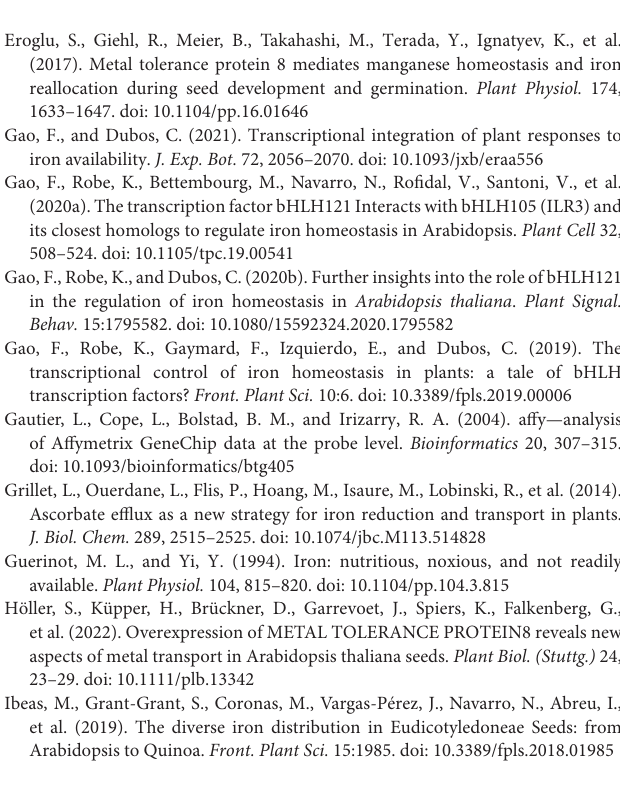
Supplementary Figure 2 | Expression of FERRITIN genes in B3 mutants. Transcriptome datasets from seeds of B3 mutants (Yamamoto et al., 2014) were obtained from the GEO database (GEO accession GSE61686). We show the log 2 normalized expression for FER1 , FER2 , FER3 and FER4 in developing seeds dissected from siliques from the abi3-6 , fus3-3, and lec2-1 mutants. DAF: days after flowering. The asterisks show means that significantly differ between mutants and their respective WT control ( t -test, p ≤ 0.05). Supplementary Figure 3 | Gene regulatory network controlling FERRITIN gene expression in seeds. We obtained a list of differentially expressed genes from seed transcriptome datasets of B3 mutants and searched for transcription factor-target gene interaction data in the plant cistrome database (O’Malley et al., 2016), the CIS-BP database (Weirauch et al., 2014) and the Arabidopsis Gene Regulatory Information Server AGRIS (Yilmaz et al., 2011) in order to build a regulatory network. Transcription factor-target gene pairs were further filtered by coexpression (expression correlation) during seed development (Schmid et al., 2005). From this network, we extracted regulatory interactions between FERRITIN genes and transcription factors and visualized the network in Cytoscape (Shannon et al., 2003). In the network, triangles represent transcription factors and rectangles represent genes. The edges connecting the nodes represent regulatory interactions from AGRIS (red edges) and CIS-BP (blue edges). Arrow edges represent positive regulation (activation) and T edges represent negative regulation (repression) based on expression correlation. Supplementary Figure 4 | Expression of VIT1 and MTP8 genes in B3 mutants. Transcriptome datasets from seeds of B3 mutants (Yamamoto et al., 2014) were obtained from the GEO database (GEO accession GSE61686). We show the log 2 normalized expression for VIT1 and MTP8 in developing seeds dissected from siliques from the abi3-6 , fus3-3, and lec2-1 mutants. DAF: days after flowering. The asterisks show means that significantly differ between mutants and their respective WT control ( t -test, p ≤